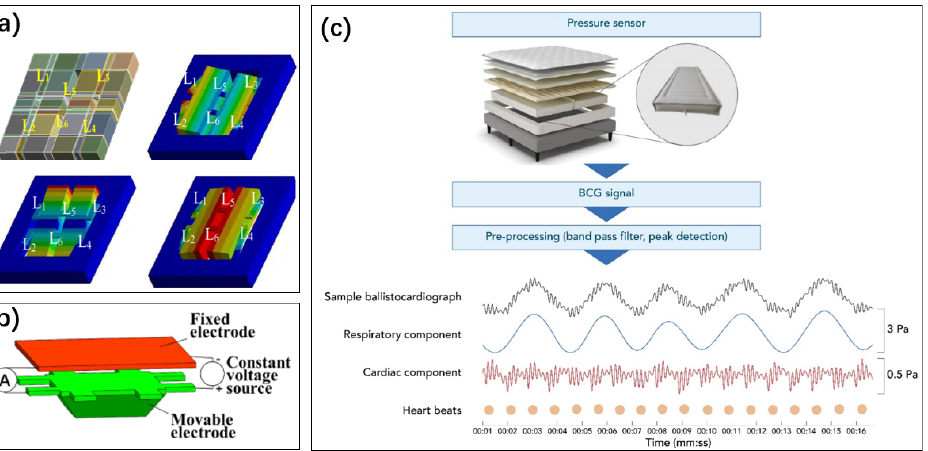
Figure 10. ( a ) Acceleration sensors made using MEMS technology, the mass block (6 L-beams L1